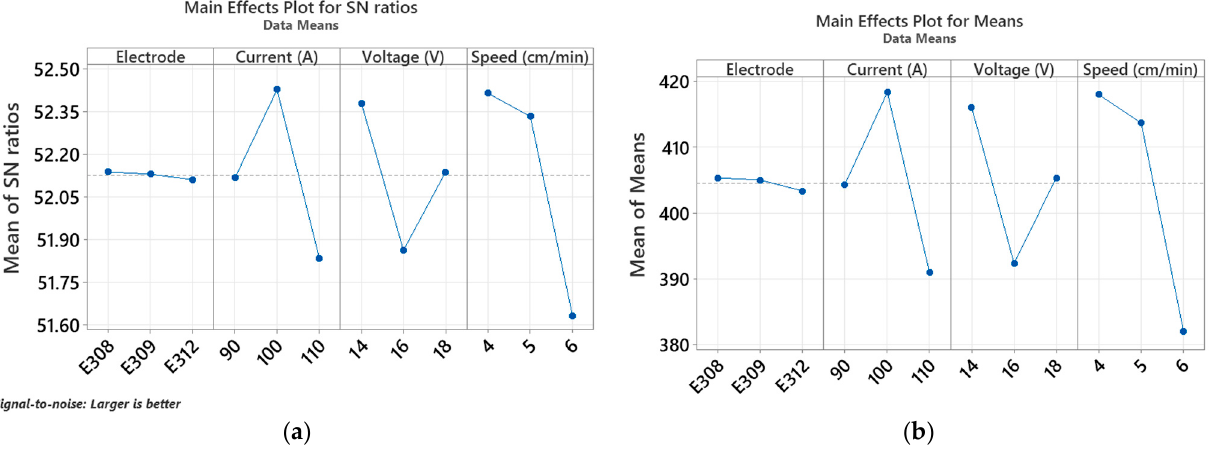
Figure 5. Response graphs of tensile strength against various factors; ( a ) Mean of S/N ratio and ( b ) Mean of Means